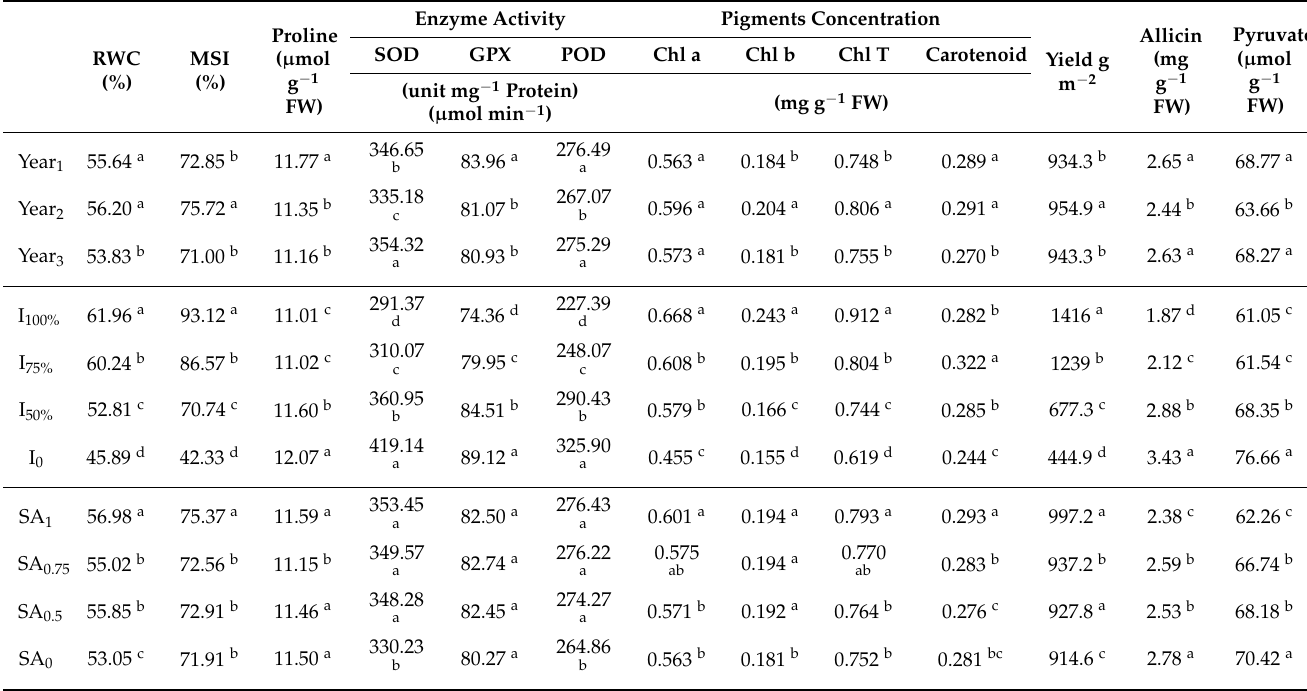
Table 2. Comparison of the mean of the main effects of irrigation levels (100, 75, 50% of plant water requirement, and non-irrigation), salicylic acid foliar application (non-use, 0.5, 0.75, and 1 mmol) and year (2016, 2017, and 2018) on the studied physiological traits in A. hirtifolium .